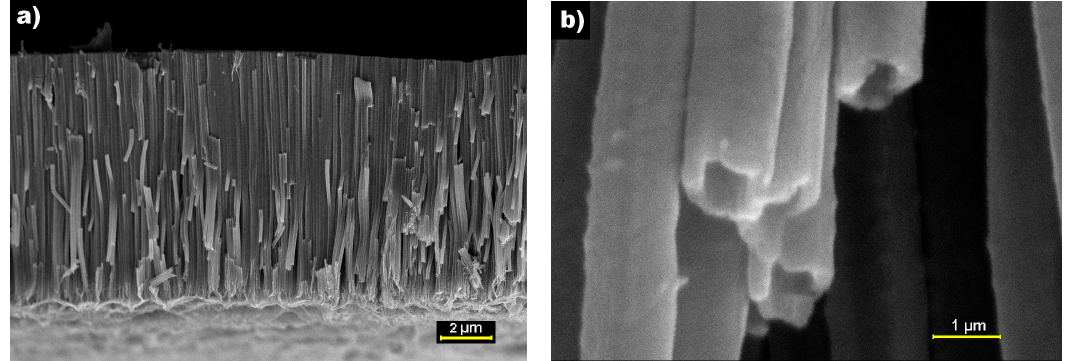
Figure 5. SEM micrograph of the TiO 2 nanotubes membrane at ( a ) low ( b ) high magnification.